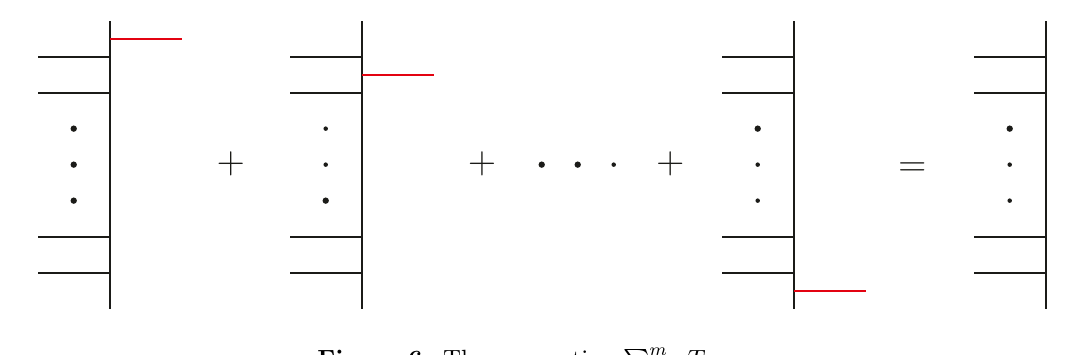
Figure 6. The summation P m